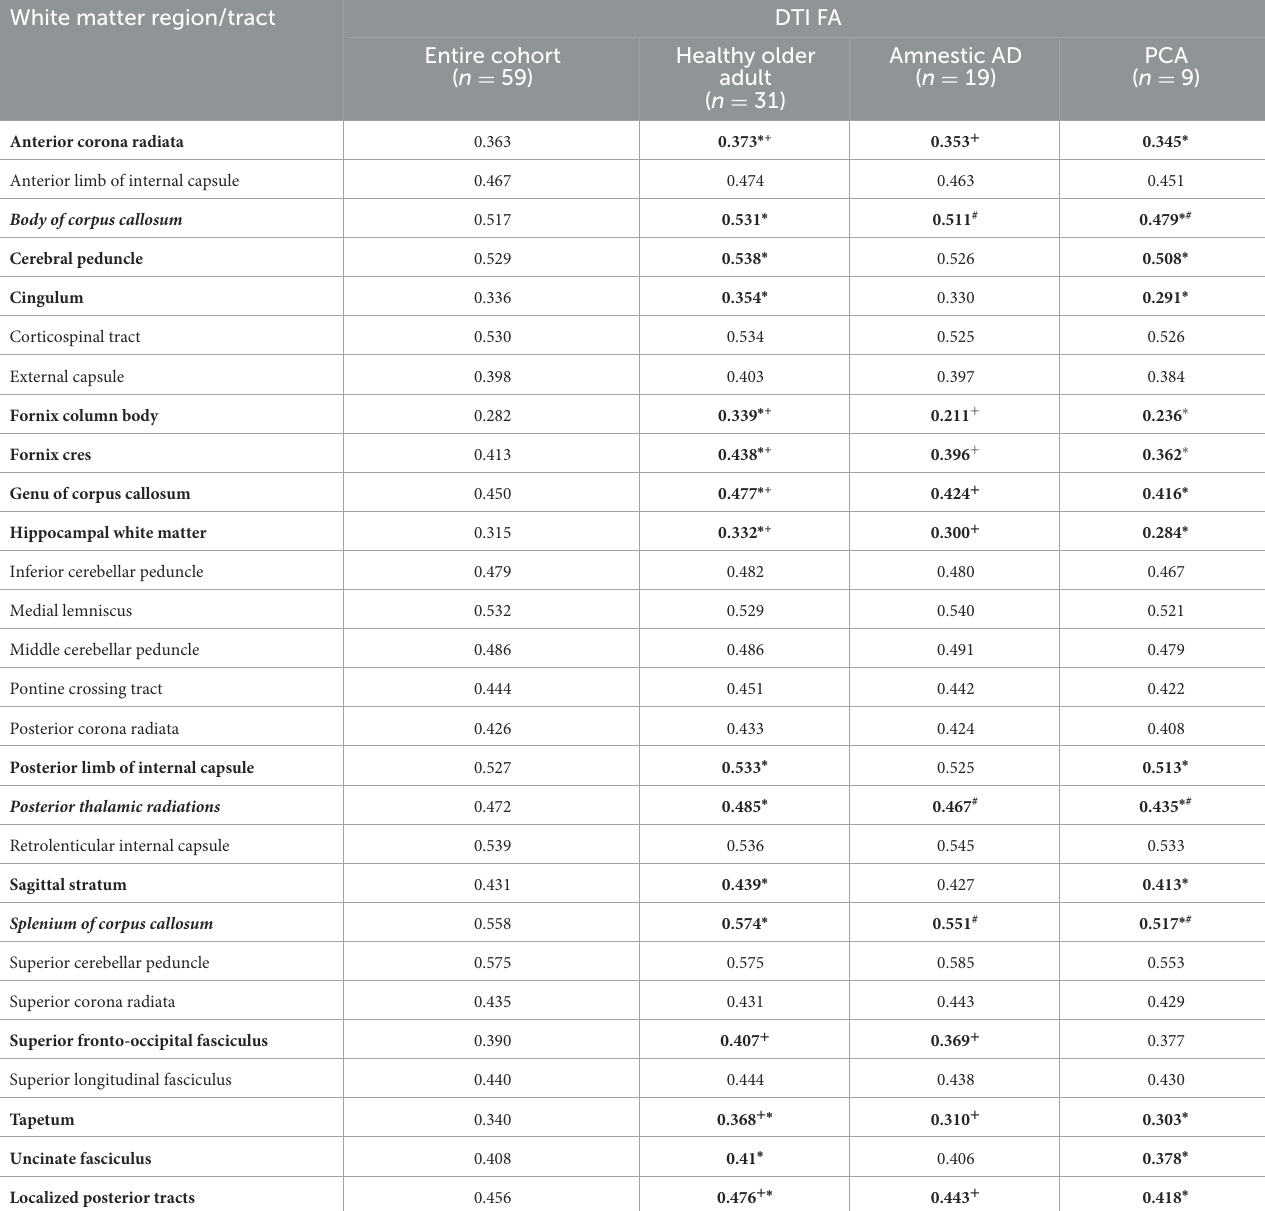
TABLE 2 Mean DTI FA for all white matter region/tracts by diagnostic group. White matter